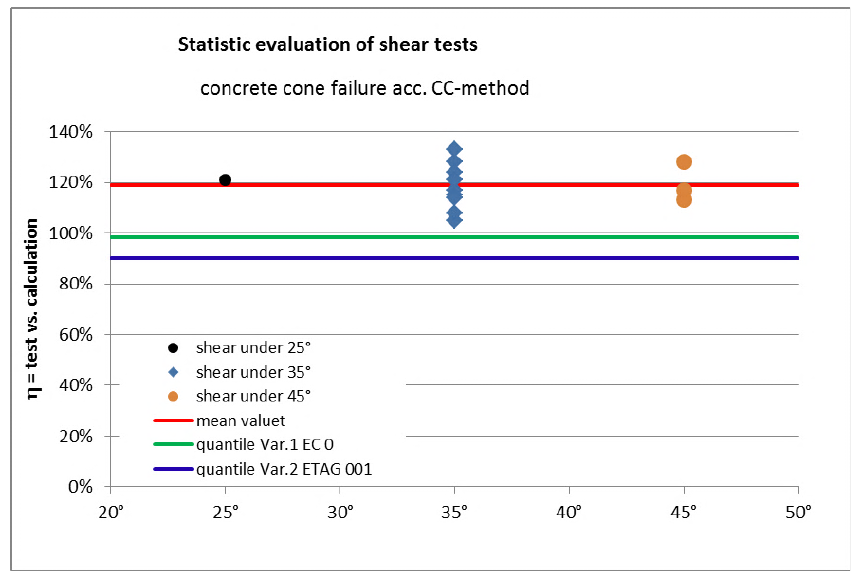
Figure 12. Test results vs. calculation results of multidirectional